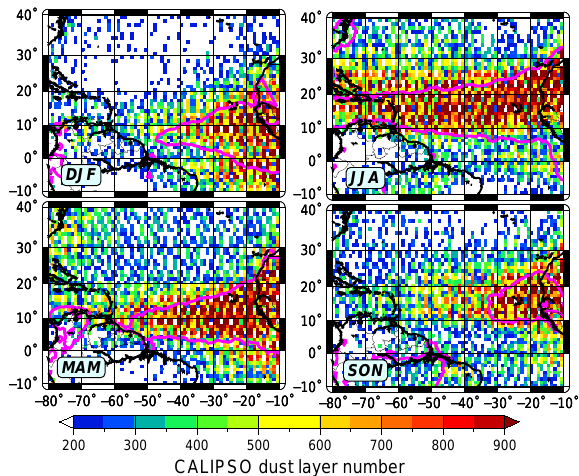
Fig. 2. Number of dust layers (desert dust and polluted dust) detected by CALIPSO above the Atlantic during 5-yr period June 2006 to May 2011 for the four seasons: winter (DJF – top left), spring (MAM – bottom left), summer (JJA – top right) and fall (SON – bottom right). The magenta lines are the 0.25 AOD isolines from MODISforeachseason.